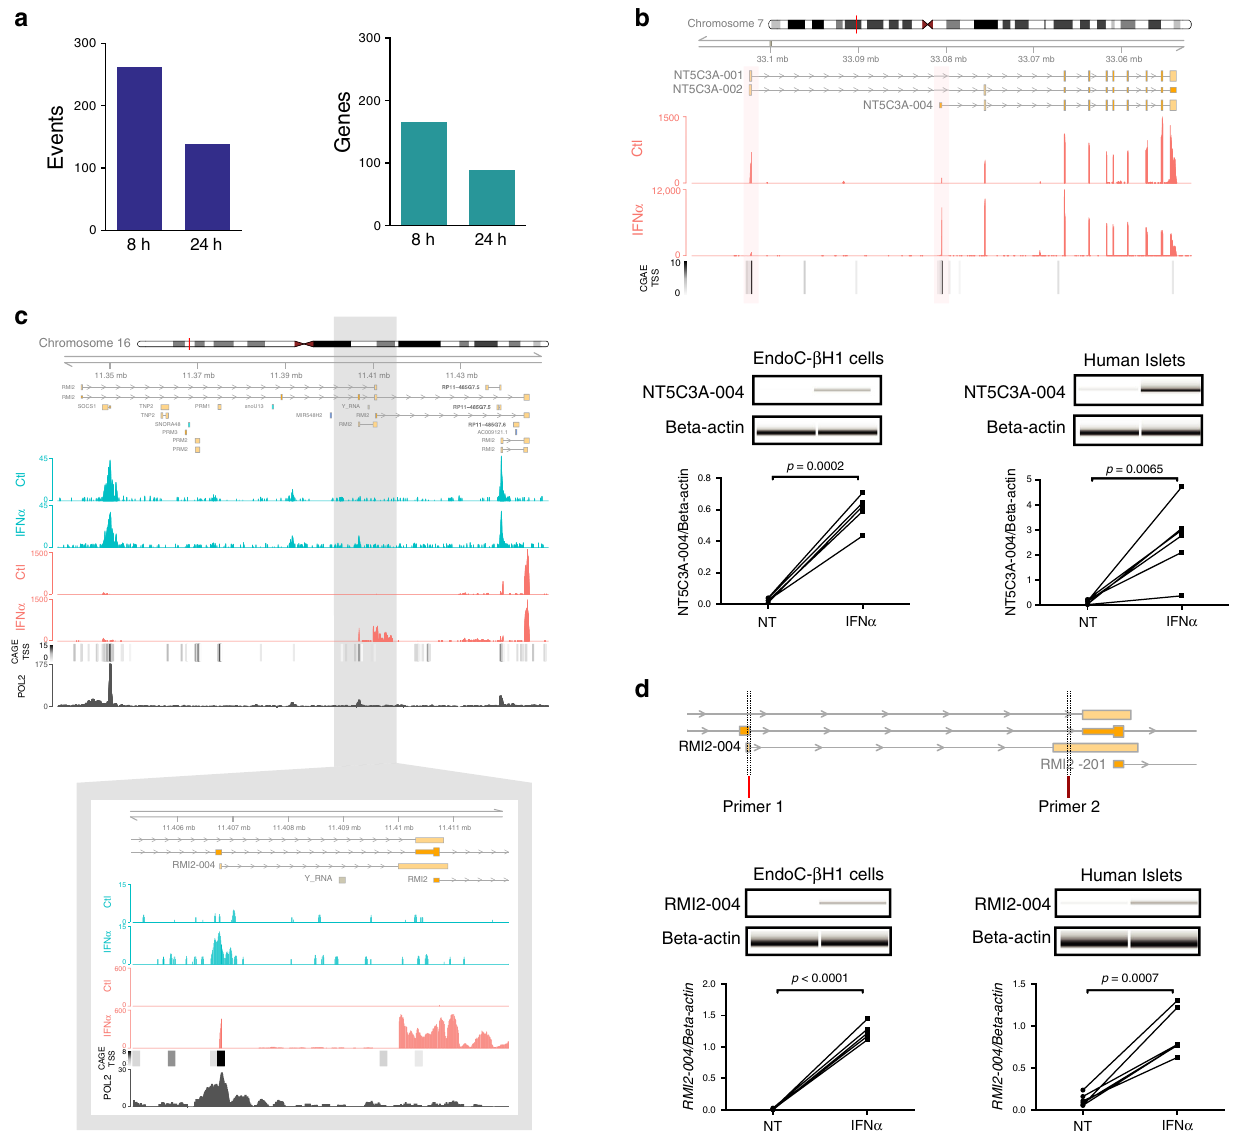
Fig. 6 Changes in the alternative transcription start site (TSS) initiation increase the repertoire of IFN α -regulated transcripts. a The tool SEASTAR 42 was used to estimate the frequency of differential alternative fi rst exon (AFE) usage induced by IFN α in human beta cells. The total number of IFN α - dependent AFEs events (left) and number of genes with AFEs (right) in the indicated time point are shown ( n = 5, Δ PSI > |0.2|, FDR < 0.05). b View of the NT5C3A locus showing the transcripts with AFE usage, the RNA-seq (red) signals of EndoC- β H1 cells exposed or not to IFN α and the CAGE TSSs information (black scale) 45 (upper panel). Con fi rmation of the AFE usage identi fi ed by SEASTAR in the gene NT5C3A (lower panel). cDNA was ampli fi ed by RT-PCR using primers located in the AFE and in its downstream exon. The PCR products were analyzed by automated electrophoresis using a Bioanalyzer 2100 and quanti fi ed by comparison with a loading control. The values were then corrected by the housekeeping gene β -actin. ( n = 4 (EndoC) and n = 6 (human islets), two-sided paired t -test). c View of the RMI2 locus showing all the transcripts in this region, the ATAC-seq (blue) and the RNA- seq (red) signals of EndoC- β H1 cells exposed or not to IFN α for 24 h, the CAGE TSSs information (black scale) 45 and RNA polymerase II ChIP-seq signal of human K562 cells exposed to IFN α (black) 48 . A higher magni fi cation of the RMI2-004 locus is presented below (image representative of 4 – 5 independent experiments). d Con fi rmation of the AFE usage in the gene RMI2. Genome mapping (upper part) showing the genomic regions used to design-speci fi c primers located in the AFE of the transcript RMI2-004 and in its downstream exon. The PCR product was analyzed by automated electrophoresis using a Bioanalyzer 2100 and quanti fi ed by comparison with a loading control. The values were then corrected by the housekeeping gene β -actin. ( n = 4 (EndoC) and n = 6 (human islets), two-sided paired t -test). Source data are provided as a Source Data fi